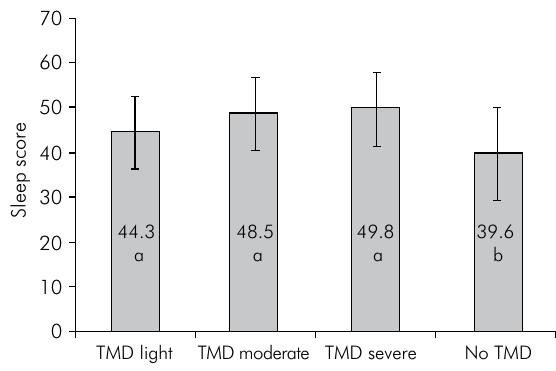
Figure 1. Correlation between the mean SAQ score and the degree of TMD.